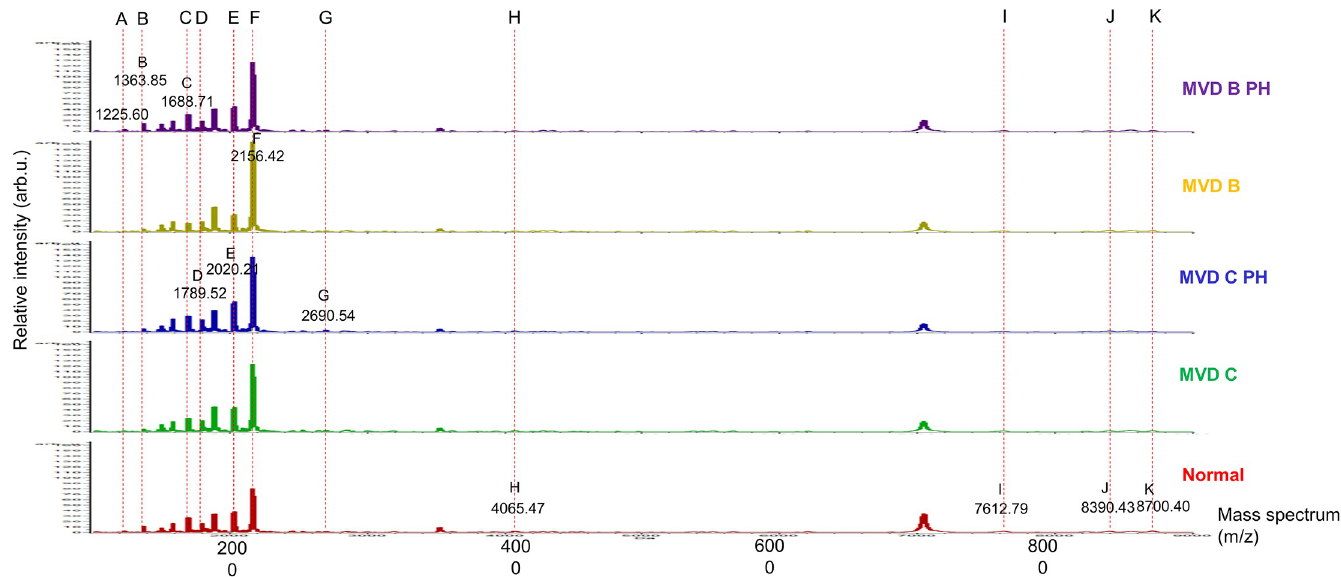
Fig 2. Peptide barcodes of dogs in the MVD stage B2 with PH (MVD B PH), MVD stage B2 (MVD B), MVD stage C with PH (MVD C PH), MVD stage C (MVD C), and normal control groups in the detection range 1,000–20,000 Da.